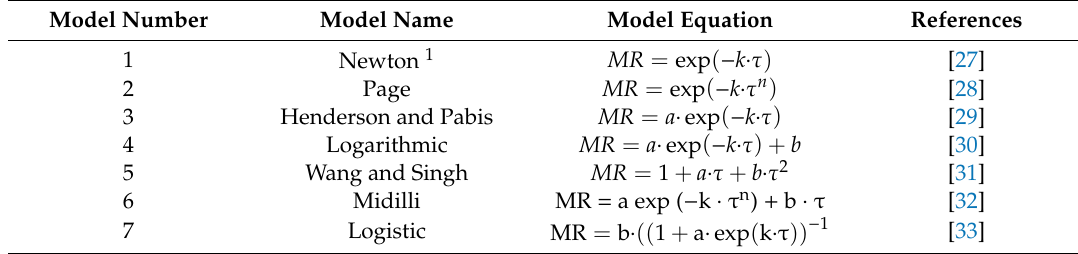
Table 1. Equations applied to the drying